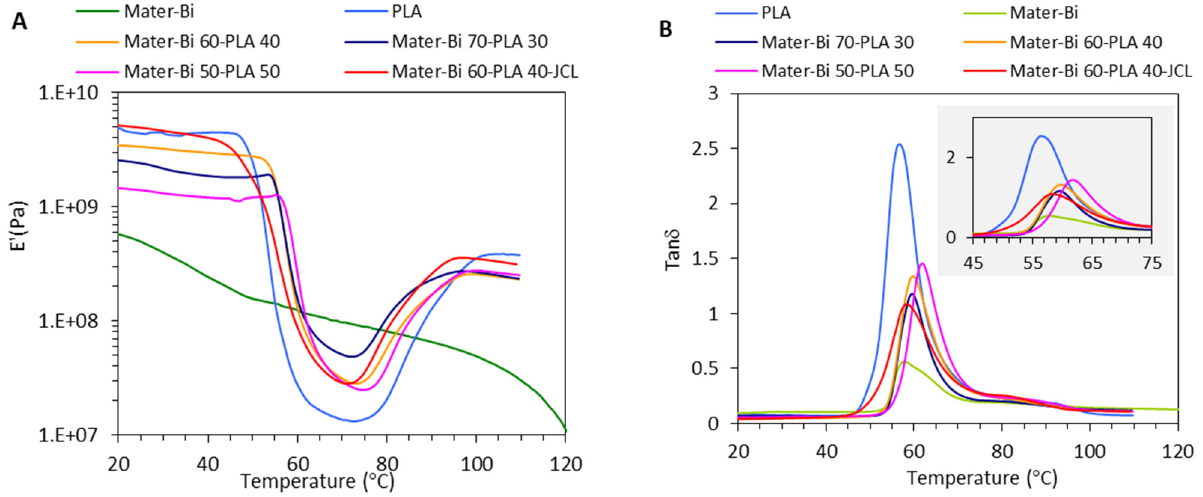
Figure 3. Storage Modulus E’ ( A ), Tan δ ( B ) versus Temperature of Mater ‐ Bi ® /PLLA blends. With the inclusion of PLLA, the E’ plateau between 20–50 °C was shifted to a higher ment with tensile ‐ test data at 25 °C. The E’ value increased from 0.77 GPa for neat Mater